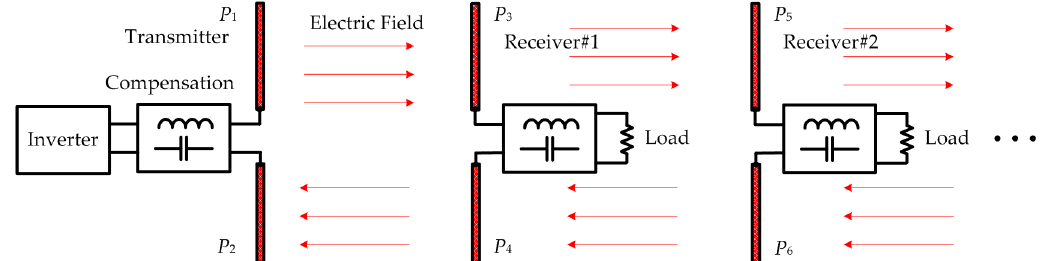
Figure 27. An electric field repeater system based on four-plate parallel coupler structure.